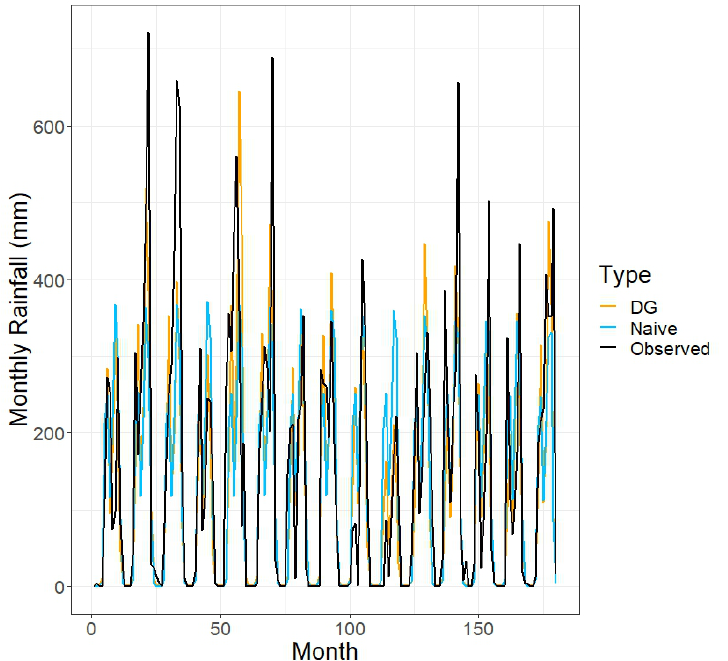
Figure 8. Three-month-ahead predicted (using the double Gaussian and naive approaches) and observed monthly rainfall values at the Liberia station from 2006 to 2020. “Month” is the number of months since January